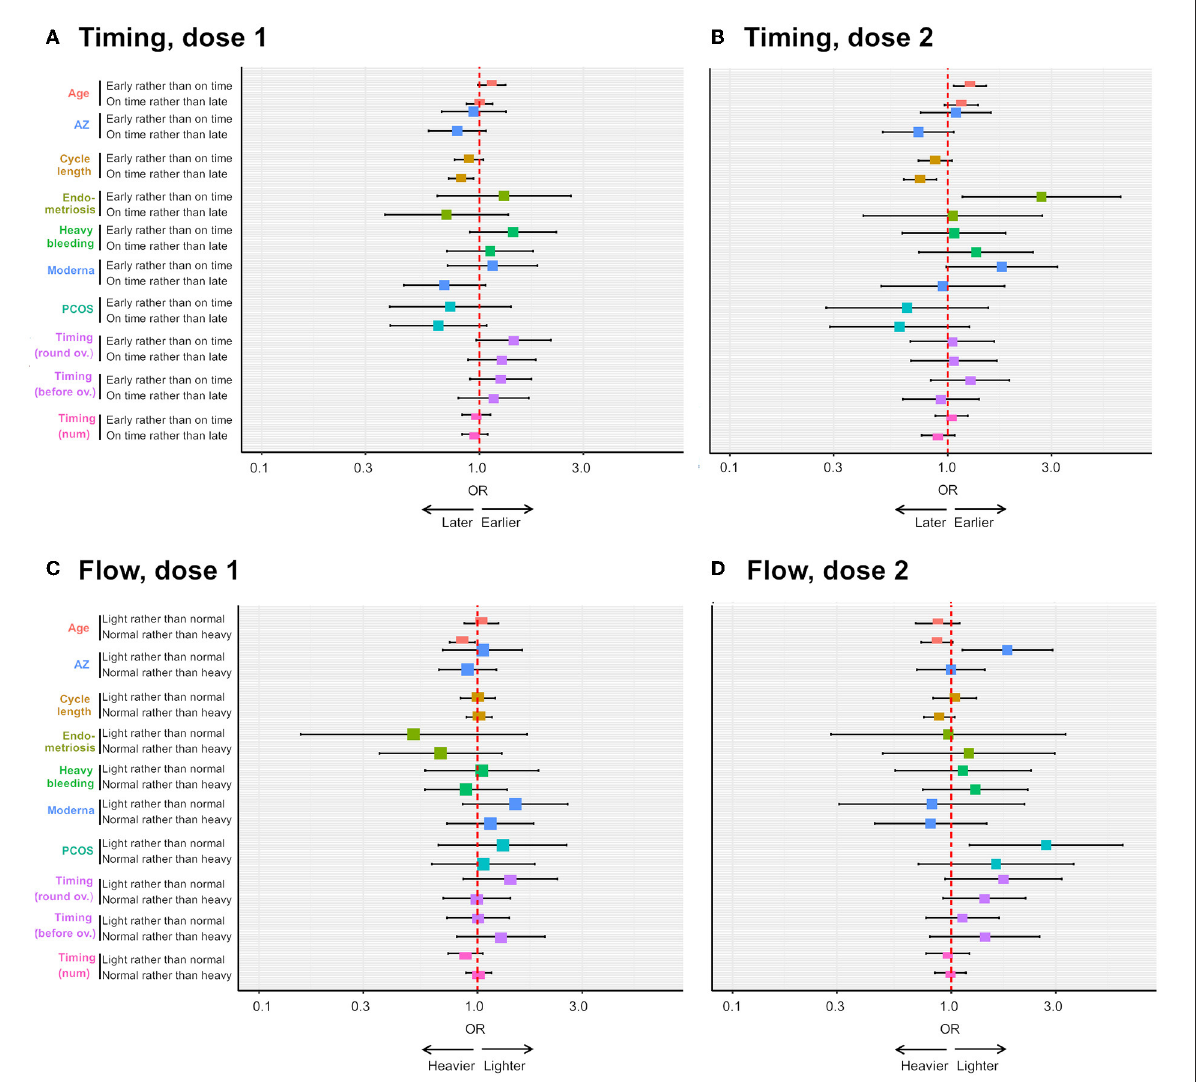
FIGURE5 Ordinal logistic regression analyses on the effects of pre-existing gynecological condition and other factors on the risk of reporting menstrual changes. The forest plots depict the odds ratio (OR) of an earlier than usual (compared to on time) or on time (compared to later than usual) period following dose 1 (A) or dose 2 (B) of COVID-19 vaccine, depending on respondent age, receipt of the AstraZeneca (AZ) or Moderna vaccine, respondent cycle length, respondent having endometriosis, heavy menstrual bleeding (“heavy bleeding”) or PCOS, timing of vaccination as a continuous variable (“timing (num)”) or timing of vaccination between 3 days before and 4 days after ovulation (“timing (round ov.)”) or timing of vaccination more than 4 days after ovulation (“timing (after ov.)”). The OR of a lighter than usual (compared to same as usual) or a same as usual (compared to heavier than usual) period following dose 1 or dose 2 of COVID-19 vaccine is shown in (C,D) , respectively, for the same explanatory